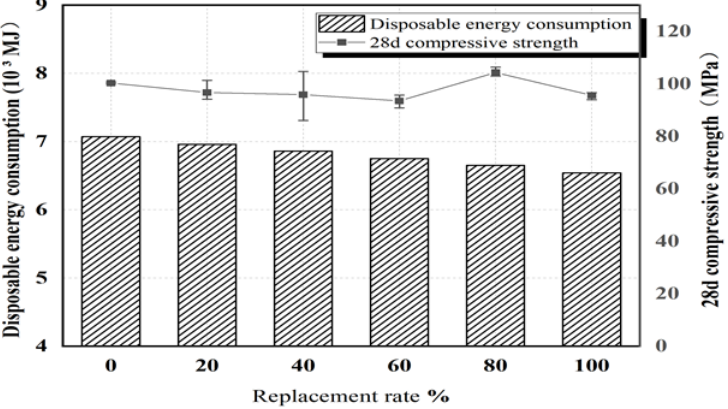
Figure 15. Comparison between primary energy consumption and 28-day compressive strength for various sand replacement rates.